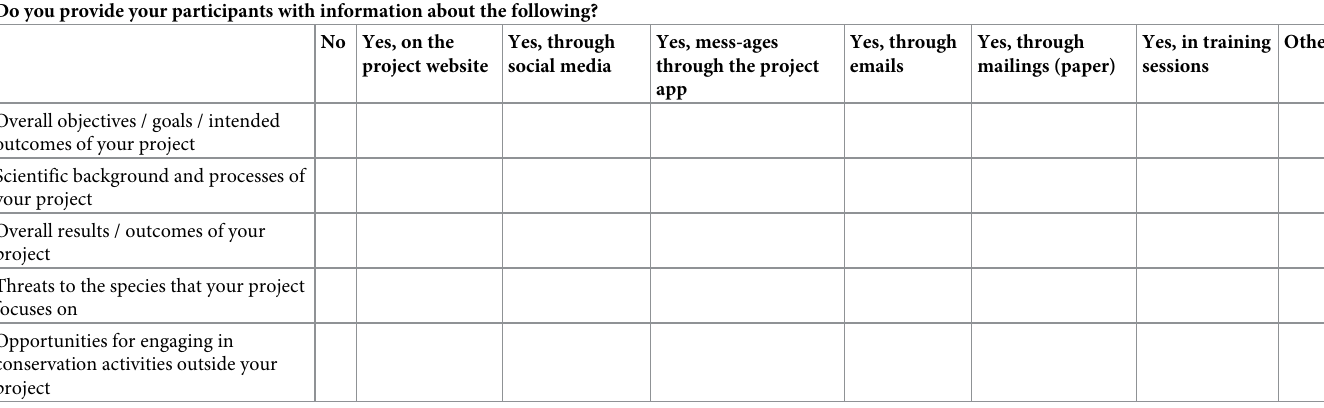
Table 2. Example of an item in the coordinator questionnaire concerning information provided to project participants. Do you provide your participants with information about the